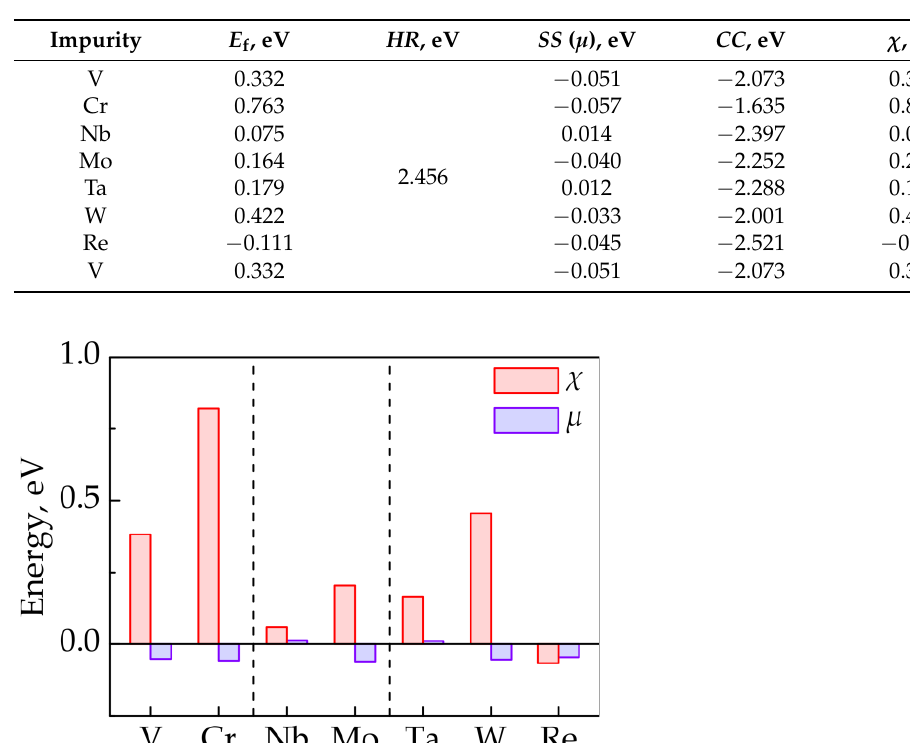
Table 1. Formation energy of the substitutional defect in Ti sublattice ( E f ), as well as the HR , SS , CC contributions.